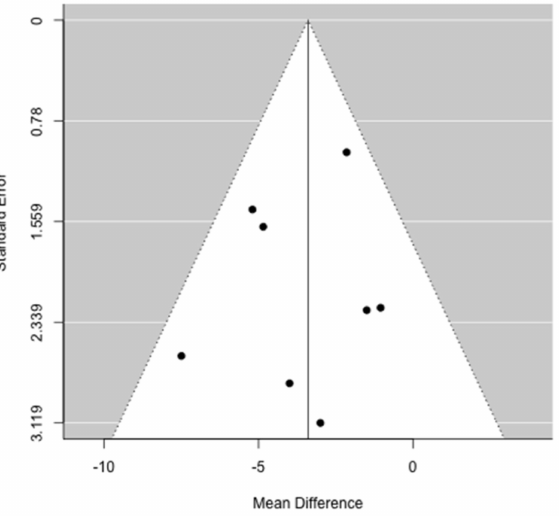
Figure 9. Funnel plot for the mean difference of overall survival. No publication bias was